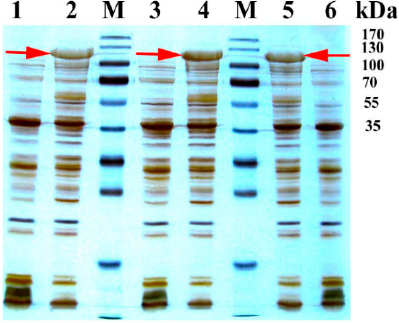
Figure 1. SDS-PAGE analysis of recombinant BM3 mutants. Crude protein extracts from a transformant expressing M01A82W (lane 2), M01A82WS72I (lane 4), M11A82W (lane 5) or empty vector (lanes 1, 3, 6). Lane M shows the proteins marker with the indicated molecular masses. The arrows indicated the recombinant BM3 proteins.